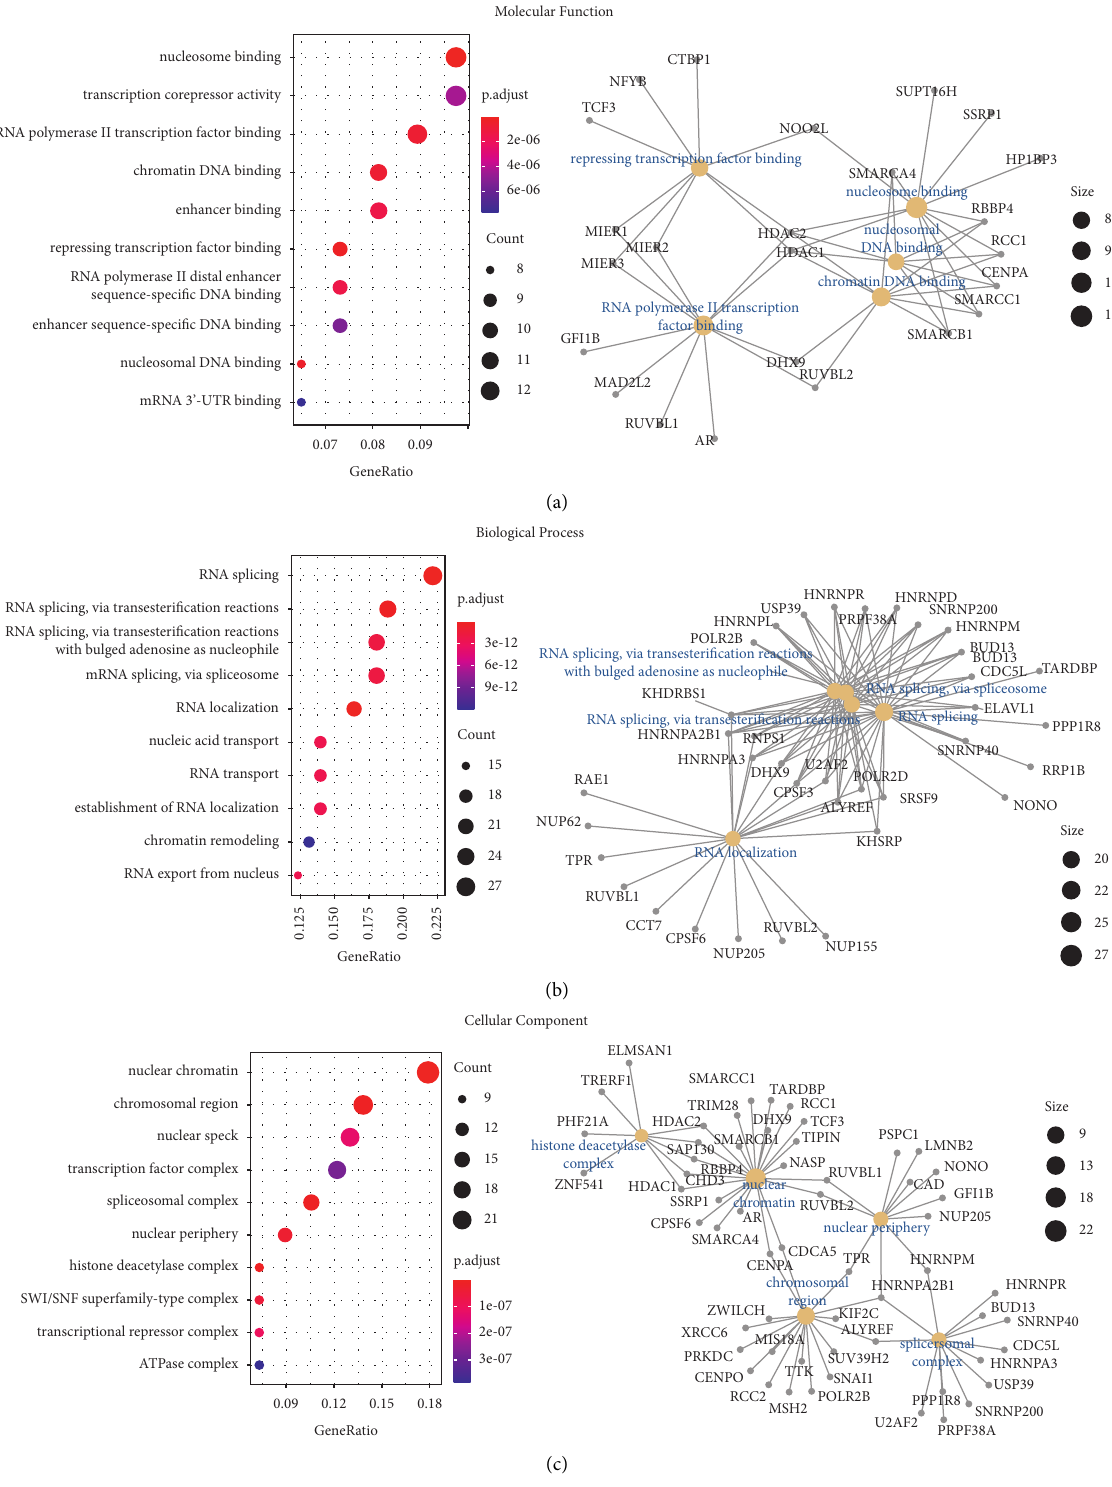
Figure 7: GO enrichment analysis of two gene sets referring to genes of KDM1A-binding and KDM1A-correlated genes. And the cnetplot for GO analysis of the first five was also shown: (a) molecular function analysis, (b) biological process analysis, and (c) cellular component